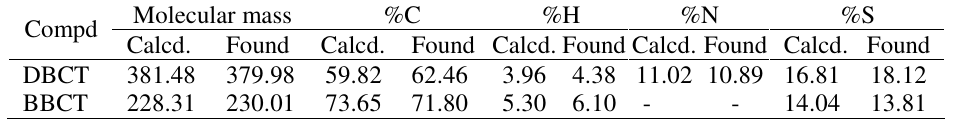
Table 2. Analytical data of the